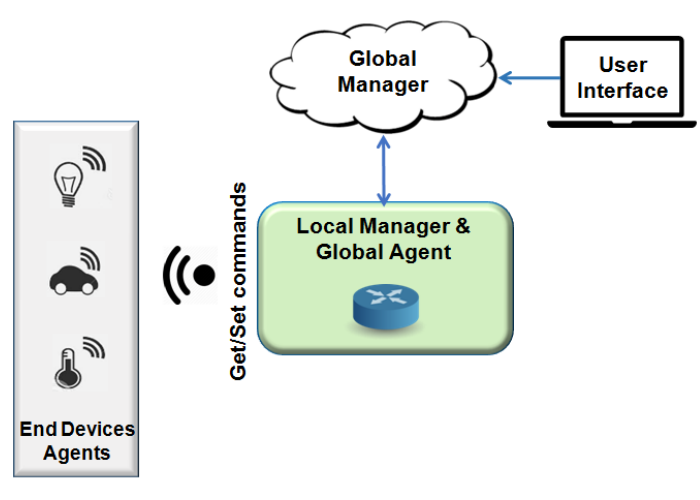
Figure 21. Illustration of the Management for the